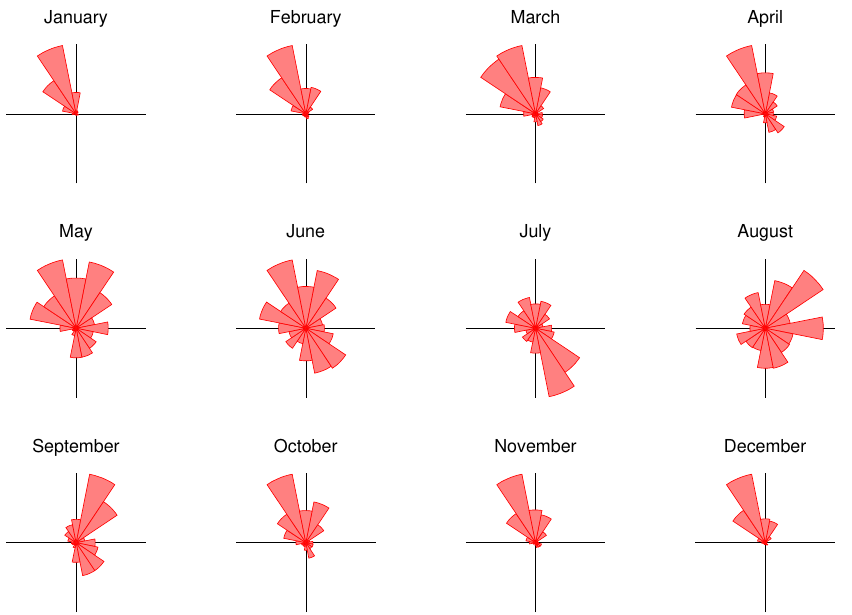
Figure 8. Monthly distributions of the dominant hourly wind direction at JMA’s Kagoshima observa- tory in